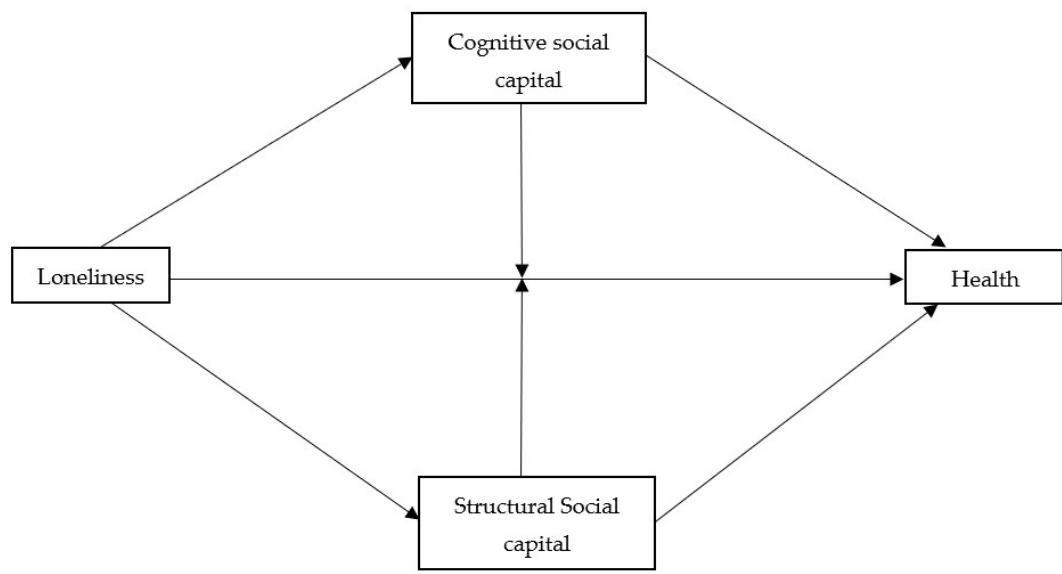
Figure 1. Hypothesised model depicting the association between loneliness and health.